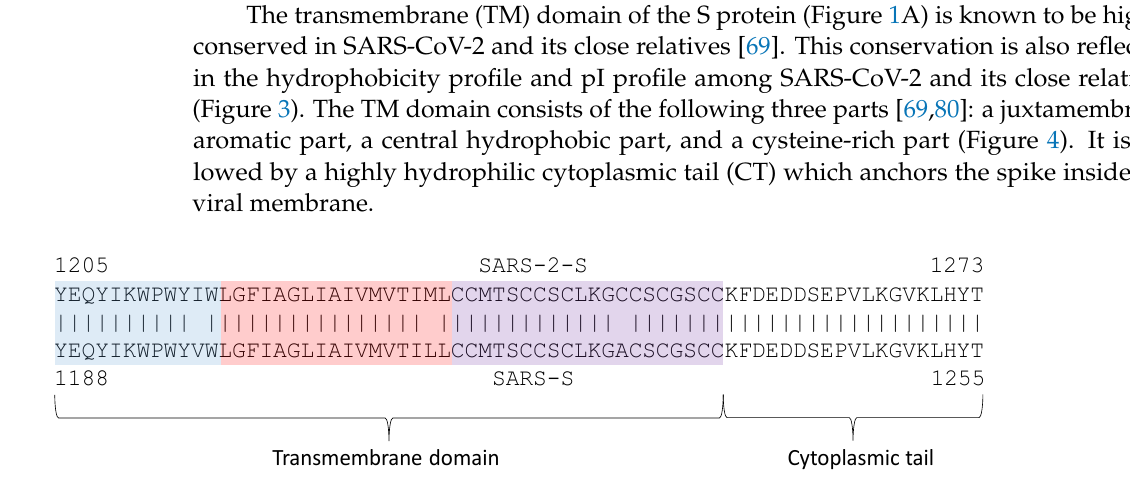
Figure 4. Transmembrane (TM) domain with its tripartite structure (juxtamembrane aromatic part in blue, central hydrophobic part in pink, and cysteine-rich part in purple) and the cytoplasmic tail that anchors inside the viral membrane.